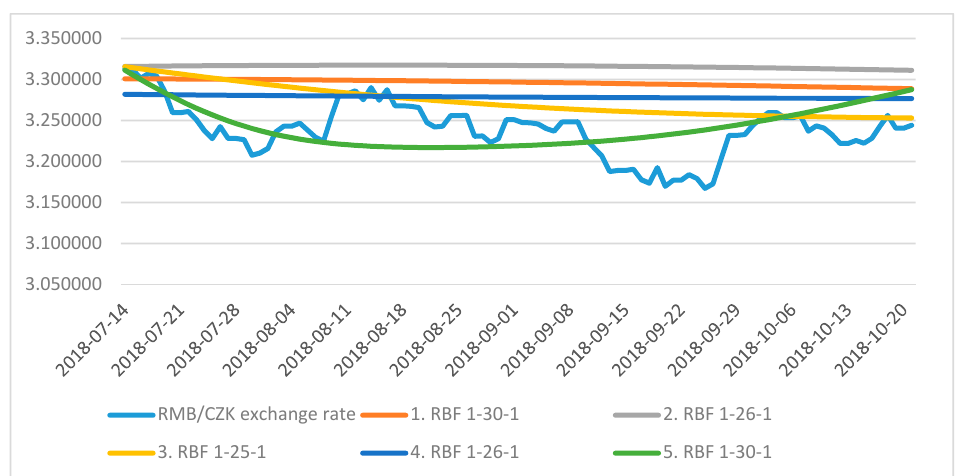
Figure 4. Actual and predicted (according to retained neural networks) development of the CZK/RMB exchange rate for the period from 14 July to 21 October 2018 (Source: Own research; according to Machova and Marecek 2019).